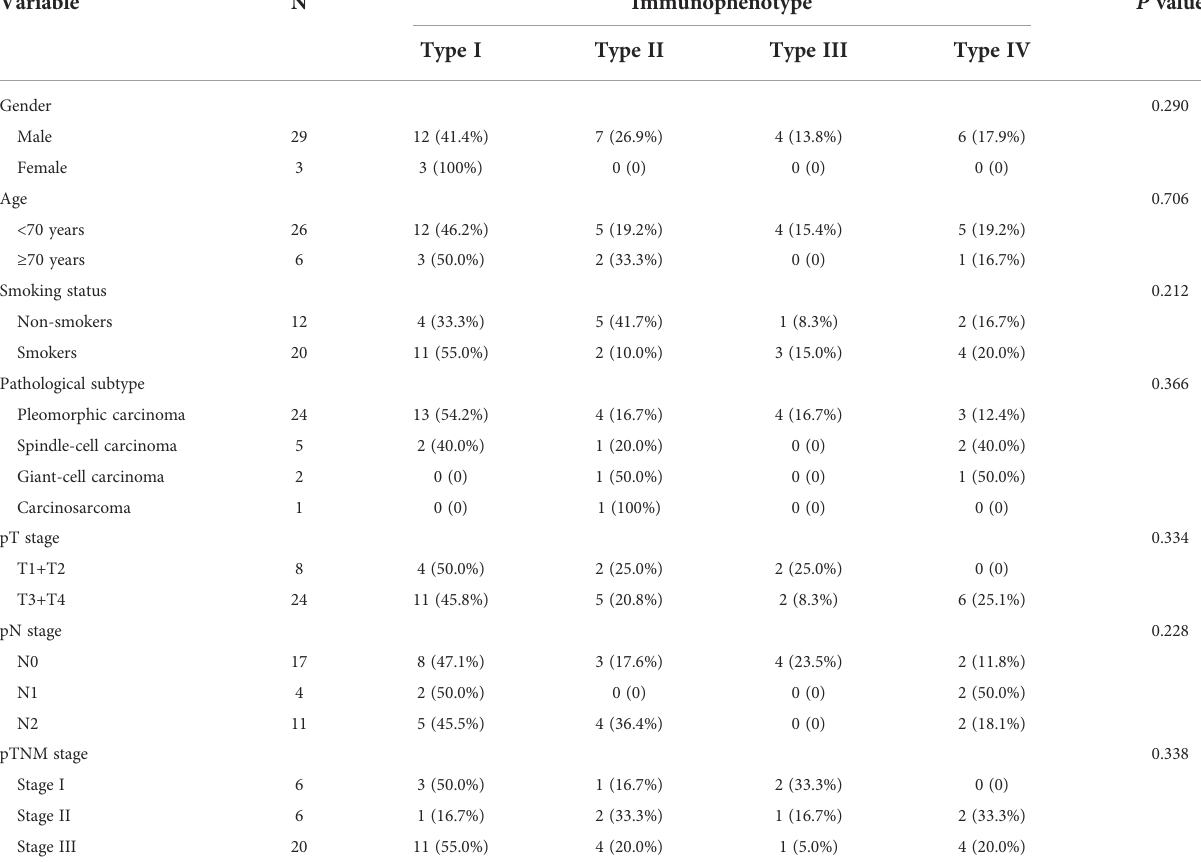
TABLE 5 Immunophenotyping of PSC based on CD8+ T cell in fi ltration and PD-L1 expression.